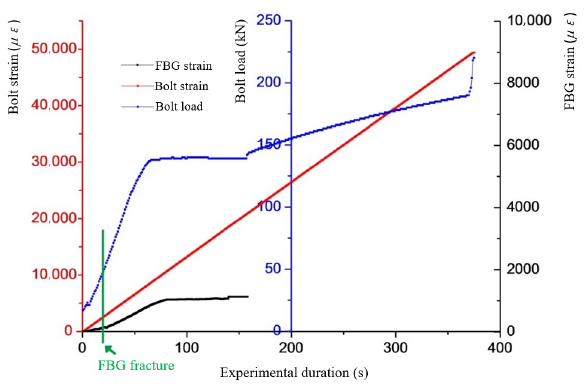
Figure 3. Variation diagram of bolt strain and load and FBG strain with time.